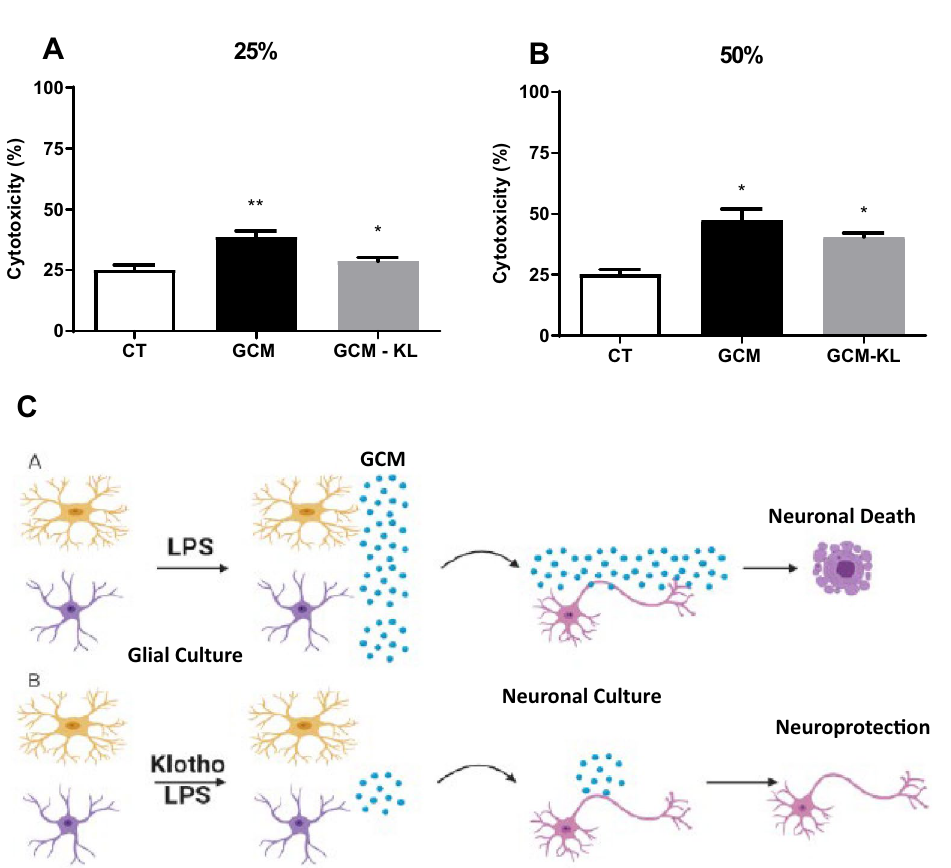
Figure 6. Effects of GCM and GCM-KL -induced cytotoxicity of primary cortical mouse neurons. The primary embryonic culture of neurons was submitted to 24-h treatment with GCM or GCM-KL in different concentrations, 25% ( A ) and 50% ( B ). Cytotoxicity was assessed by the LDH assay. One-way ANOVA analysis, followed by Tukey’s post-test, *p < 0.05, **p < 0.01. Results are presented as mean ± SEM of 5 independent experiments. ( C ) Representative schedule of the anti-inflammatory and neuroprotective effect of α-Klotho protein. LPS induces GCM to produce pro-inflammatory mediators that can lead to neuronal death ( A ). α-Klotho protein decreases the production of pro-inflammatory mediators induced by LPS in GCM ( B ), and it can have a protective effect on neurons from the neurotoxic effects of LPS induced by GCM. The figure was “Created with BioRender.com—Agreement number FH248VCXX8 to Scientific